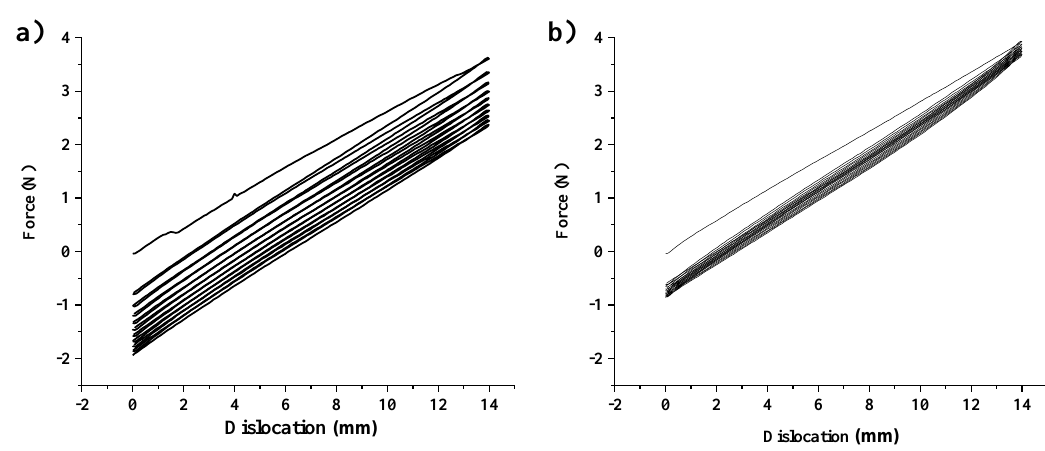
Figure 7. Loading-unloading curves obtained from the cyclic loading tests for: ( a ) PDMS; ( b ) N1 coated PDMS.